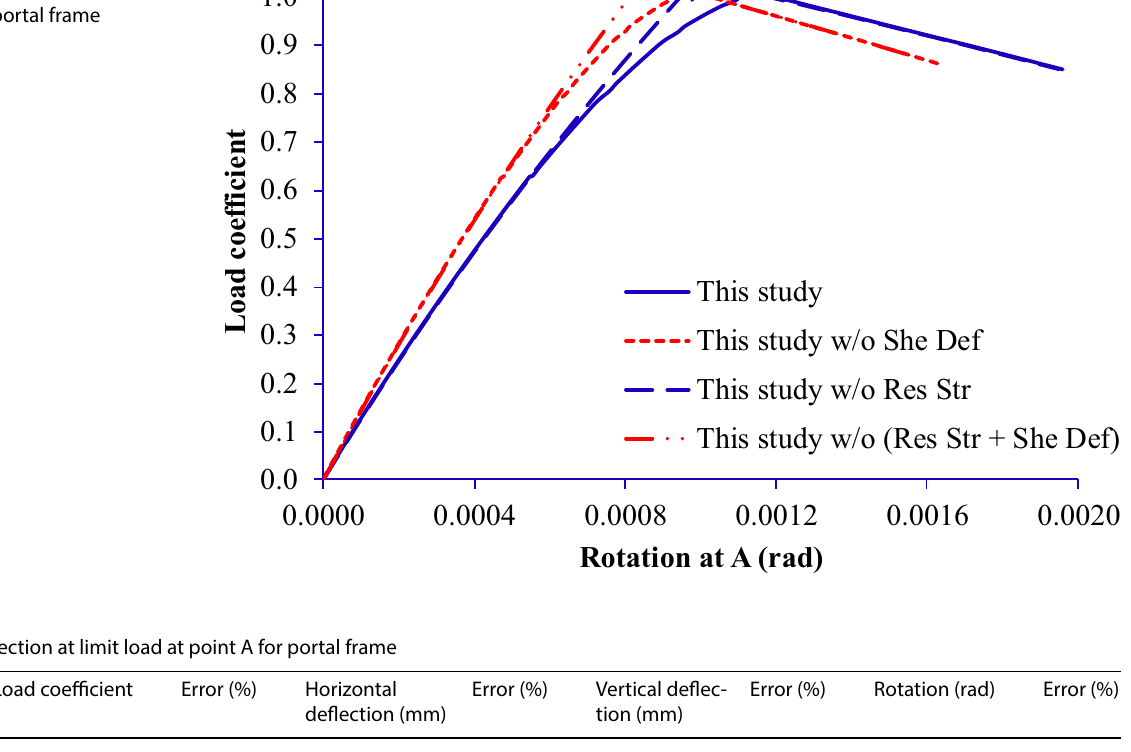
Fig. 9 Load-rotation relation- ship at A of portal frame